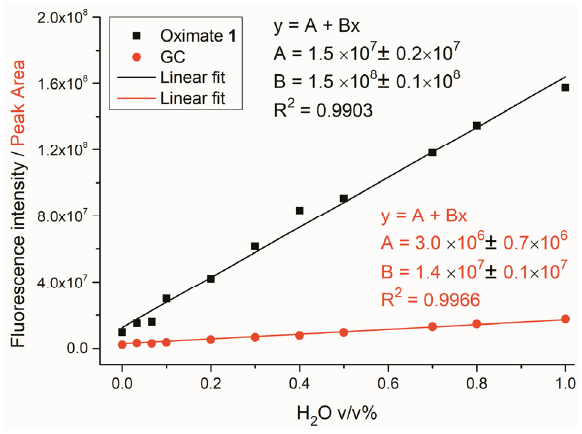
Figure 7. Calibration curves for low-level water content determination in acetonitrile using investigated oxime 1 based fluorescent “turn-on” chemosensor and gas chromatography with mass spectrometry (GC-MS) detection (capillary column coated with a 0.2 μ m film thickness of ionic liquid SPB-IL100 as stationary phase was used; v/v (%)—volume of water/volume of solution in %).